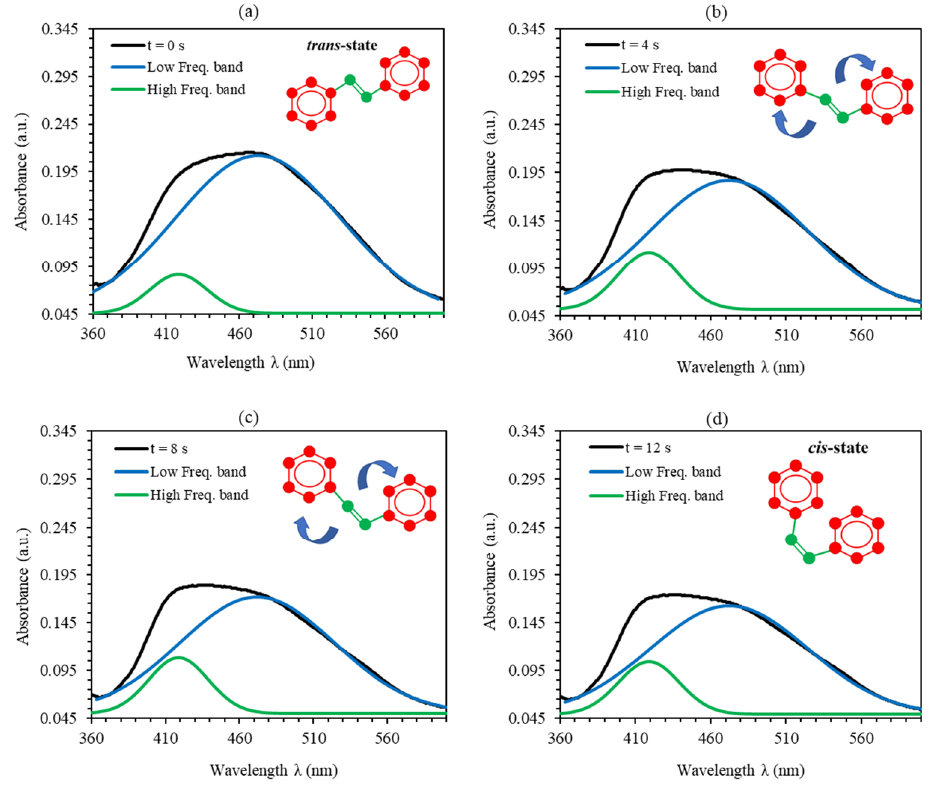
Figure 5. Double peaks fit for the absorbance spectra of PMMA-BDK-MR polymer composite thin film for various UV-illumination times, ( a ) Natural trans -case, ( b ) trans / cis -transformation case (1) after 4 s, ( c ) trans / cis -transformation case (2) after 8 s, and ( d ) cis -state after 12 s.